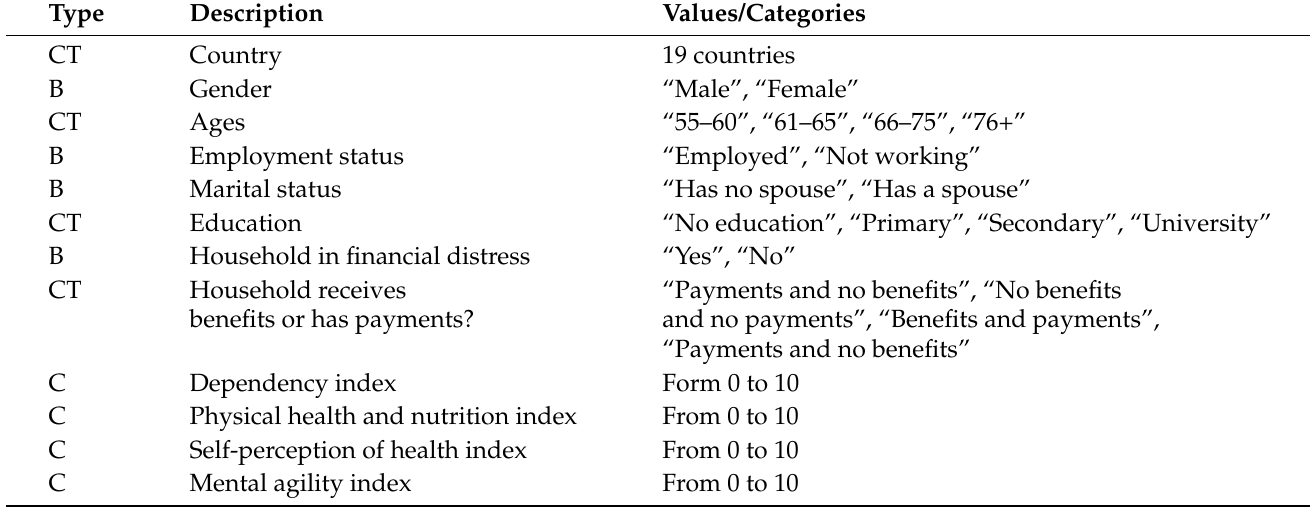
Table 1. Descriptive variables included in the analysis and their possible values or